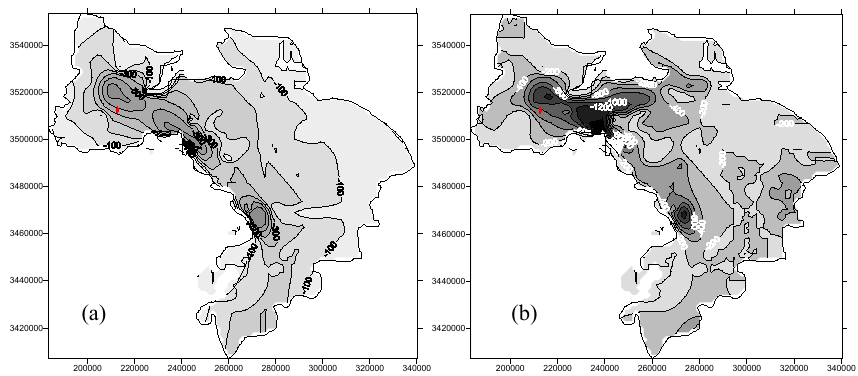
Figure 4. Cumulative land subsidence (mm) from 1980 to 1995 (a) and 2001 (b) . The red line represents the earth fissure at Guangming